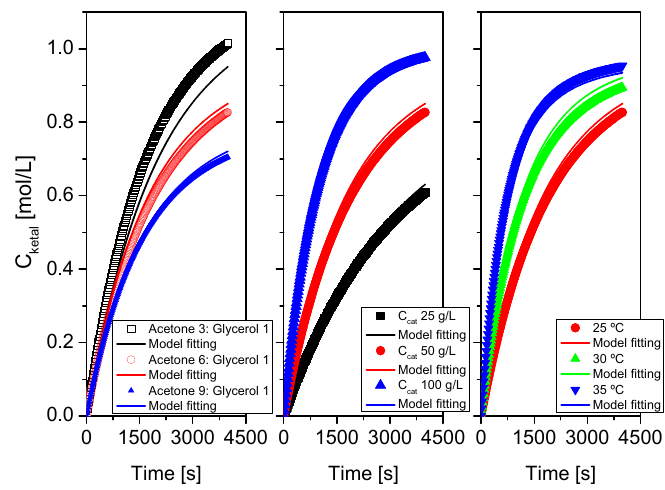
Figure 16. Fit of the proposed kinetic model to all data from system 1 (acetone+glycerol). Points correspond to the experimental data while lines show the fit of the model to such data.